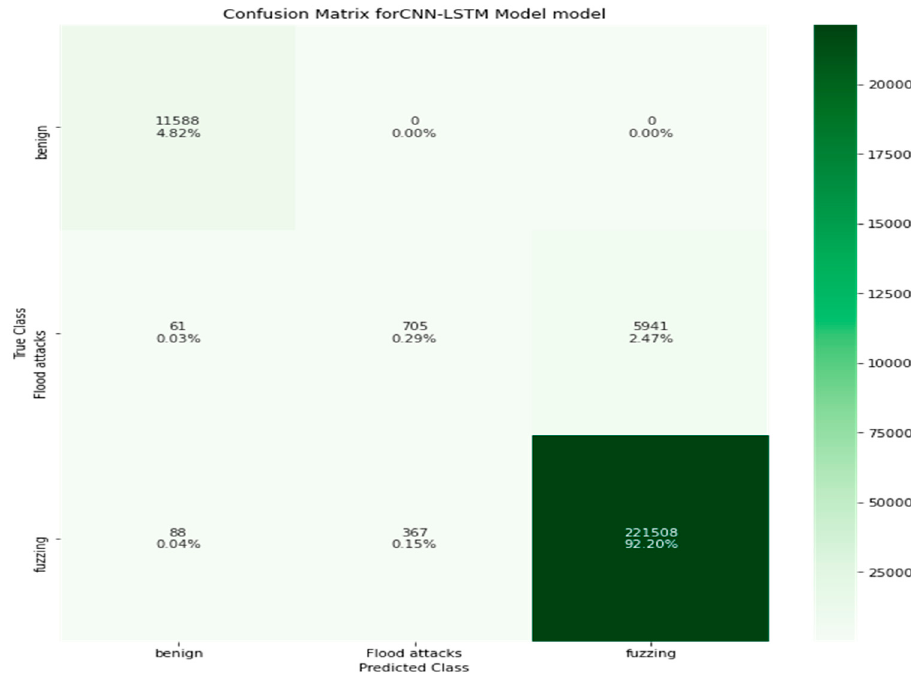
Figure 12. The confusion metrics of the CNN–LSTM model in the detection of the flood, fuzzing, and normal packets in a CAN bus network.